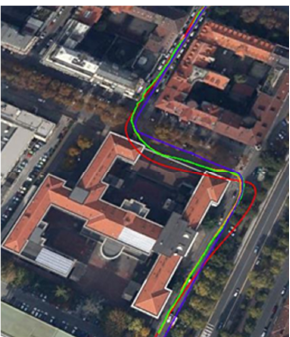
Figure 13. UKF not-augmented smoothed trajectories: in blue the INS, in red 4 states, in orange 5 states, in green 6